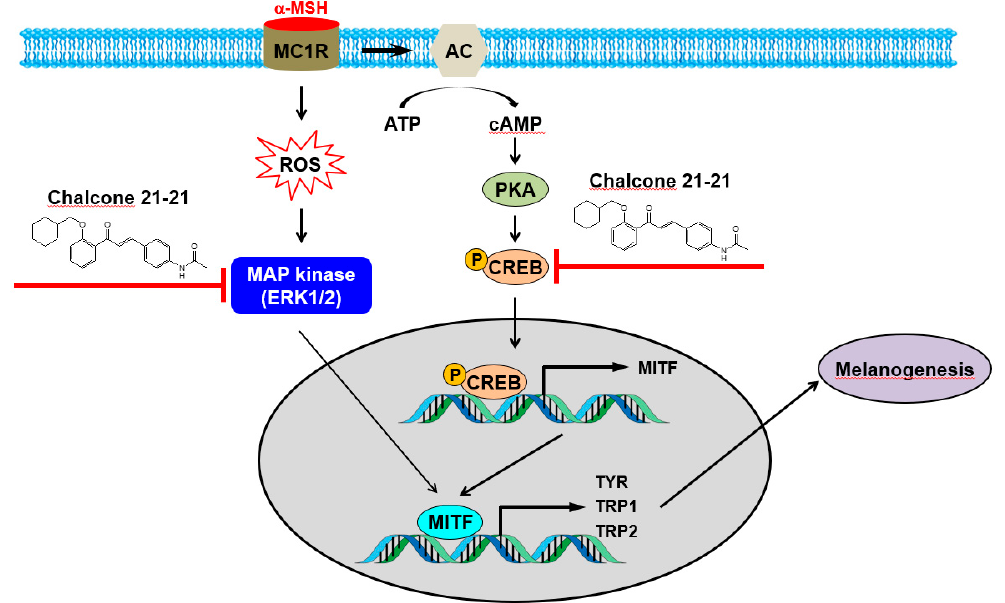
Figure 6. A schematic diagram illustrating the proposed action mechanisms of chalcone 21-21. Chalcone 21-21 specifically targets the ERK / CREB signaling, thereby inhibiting MITF and MITF-regulated target genes including those encoding tyrosinase, TRP1, and TRP2. AC, adenylate cyclase; α -MSH, alpha-melanocyte stimulating hormone; ATP, adenosine triphosphate; cAMP, cyclic adenosine monophosphate; CREB, cAMP response element-binding protein; ERK, extracellular signal-regulated kinase; MAP kinase, mitogen-activated protein kinase; MC1R, melanocortin receptor type 1; MITF, microphthalmia-associated transcription factor; PKA, protein kinase A; ROS, reactive oxygen species; TRP, tyrosinase-related protein; TYR, tyrosinase.